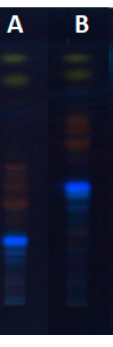
Figure 7. HPTLC chromatograms of Japanese knotweed rhizomes STS (2 μ L, 50 mg/mL in 70% acetone( aq )) developed up to 9 cm with toluene–acetone–formic acid (6:6:1, v / v ) ( A ), toluene–acetone– formic acid (3:3:1, v / v ) ( B ), toluene–acetone–formic acid (3:6:1, v / v ) ( C ) and dichloromethane–